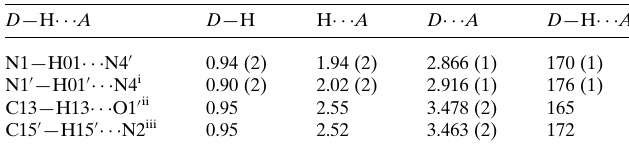
Table 1 Hydrogen-bond geometry (A˚ , (cid:2) ).